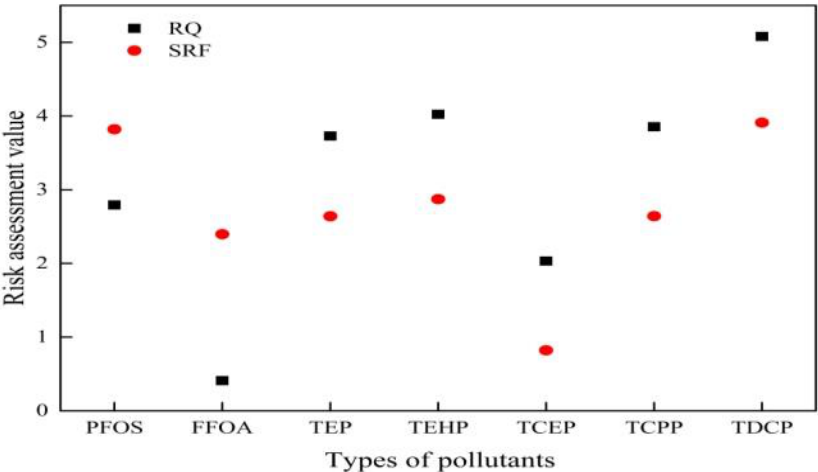
Figure 3. Environmental risk level assessment of perfluorinated compounds and organophosphate esters using RQ and SRF.